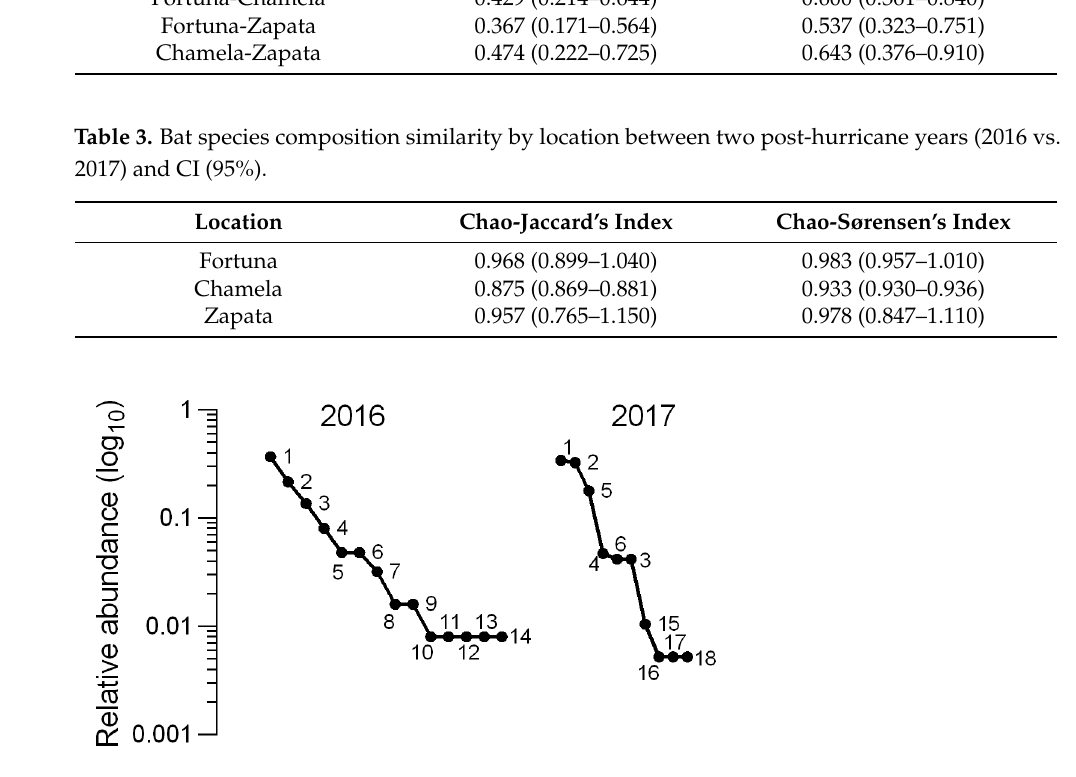
Figure 3. Rank-abundance curves of bat species captured in 2016 and 2017 in Chamela, Jalisco. 1: Artibeus jamaicensis , 2: Desmodus rotundus , 3: A. lituratus , 4: Dermanura phaeotis , 5: Pteronotus mexi-